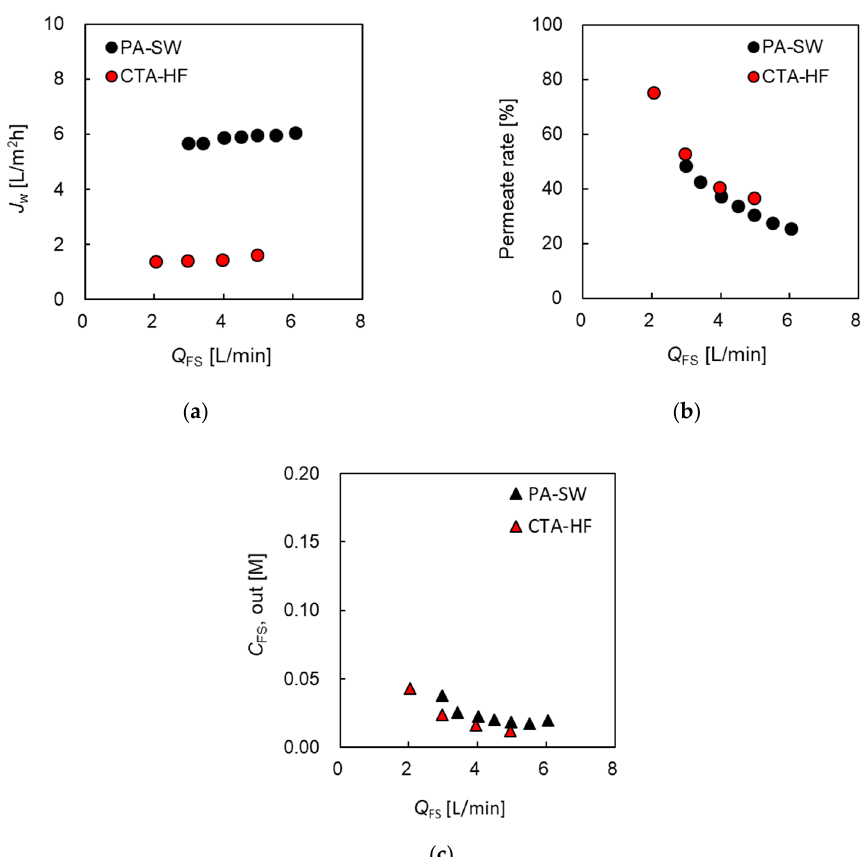
Figure 4. ( a ) Water flux, J w , and ( b ) FS permeation rate, η , and ( c ) the concentration of the module outlet at FS side ( C FS,out ), respectively, as a function of FS flow rate, Q FS . DS: 0.6 M NaCl. FS: treated tap water. Flow rate of DS ( Q DS ): 10.0 L/min. Hydrostatic pressure ( Δ P ): 1.2 MPa.